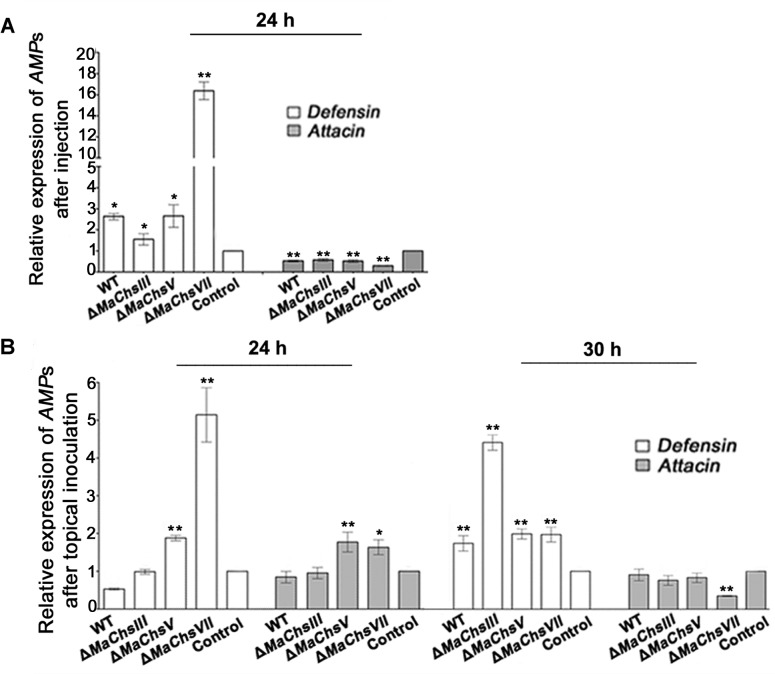
Expression analysis of antimicrobial peptide genes (AMPs) in locust.(A) The relative expression levels of Defensin and Attacin at 24 h after injection. (B) The relative expression levels of Defensin and Attacin at 24 h and 30 h after topical inoculation. The locusts without treatment were used as the control. A single asterisk above bars denotes significant difference, P < 0.05; double asterisks above bars denote significant difference, P < 0.01. Error bars indicate standard errors of three trials.